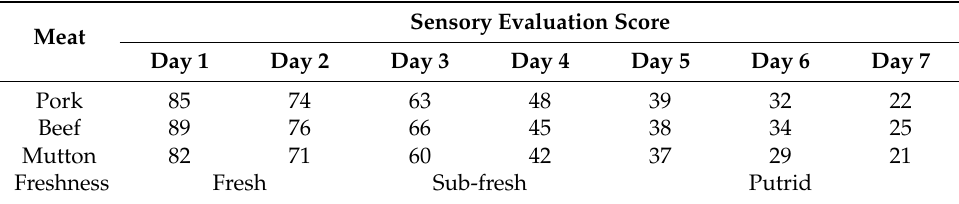
Table 2. Human sensory evaluation results of pork, beef and